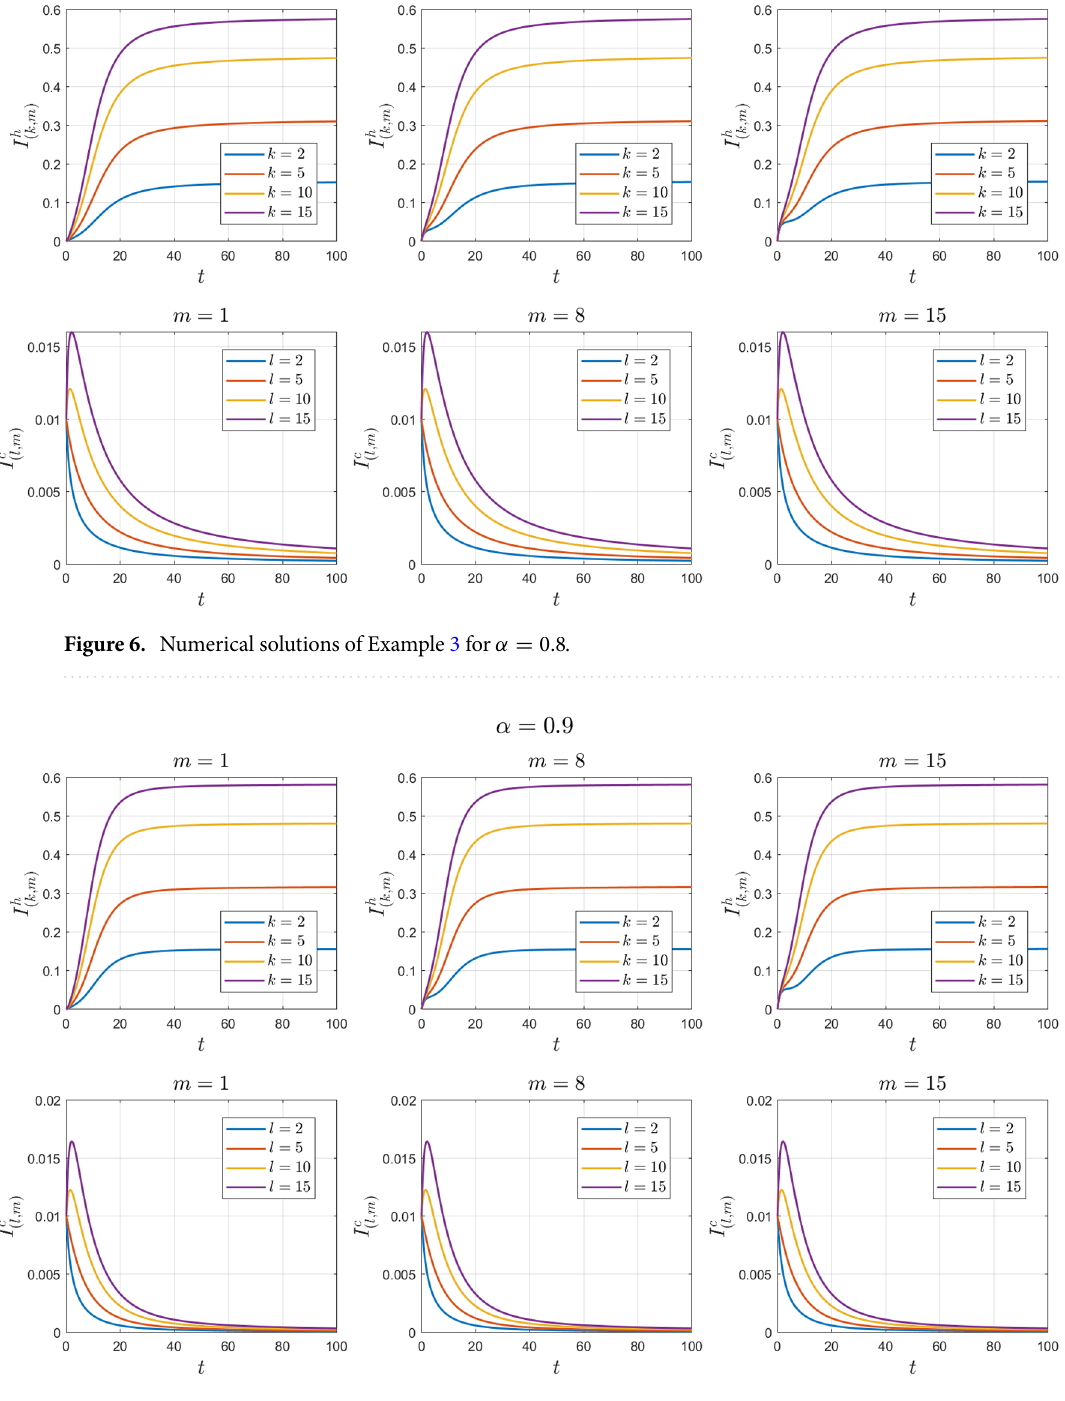
Figure 7. Numerical solutions of Example 3 for α = 0.9